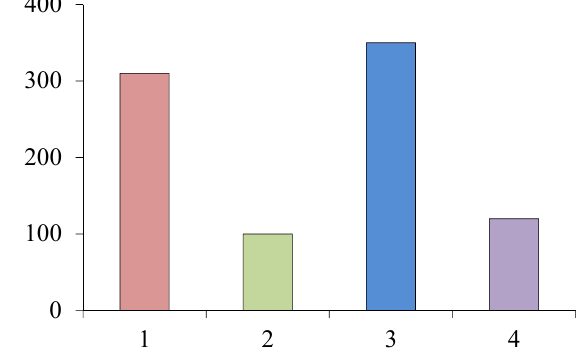
Fig. 10. Diagram of comparison of the energy value of marmalade: (1) "Jelly-fruit" based on agar (control); (2) "Solnechnoe utro" based on agar; (3) "Jelly-fruit" based on pectin (control); (4) "Uslada" based on